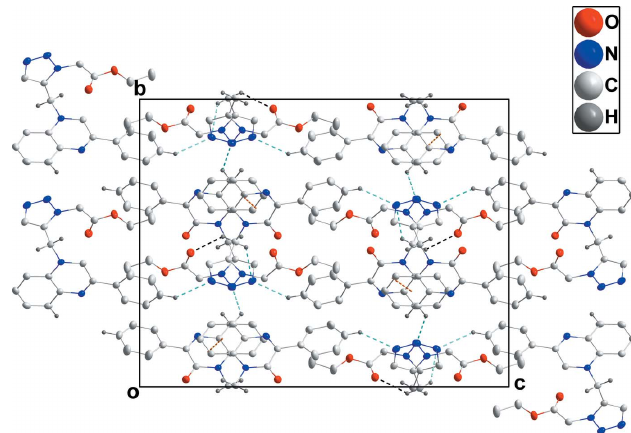
Figure 2 Packing viewed along the a -axis direction. C—H (cid:3)(cid:3)(cid:3) O and C—H (cid:3)(cid:3)(cid:3) N hydrogen bonds are shown, respectively, by black and light-blue dashed lines while the (cid:2) -stacking interactions are shown by orange dashed lines.